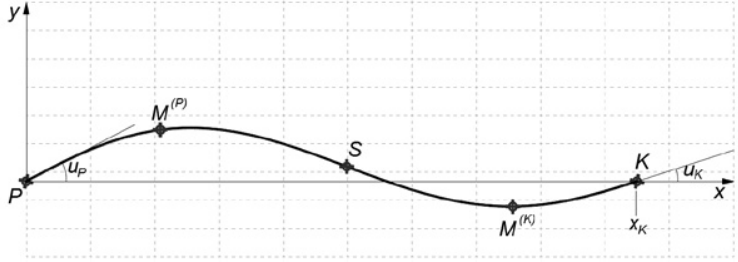
Note: M(P), M(K) − points of maximum curvature in the first and second section of the Figure 2. S -shaped transition curves for tan